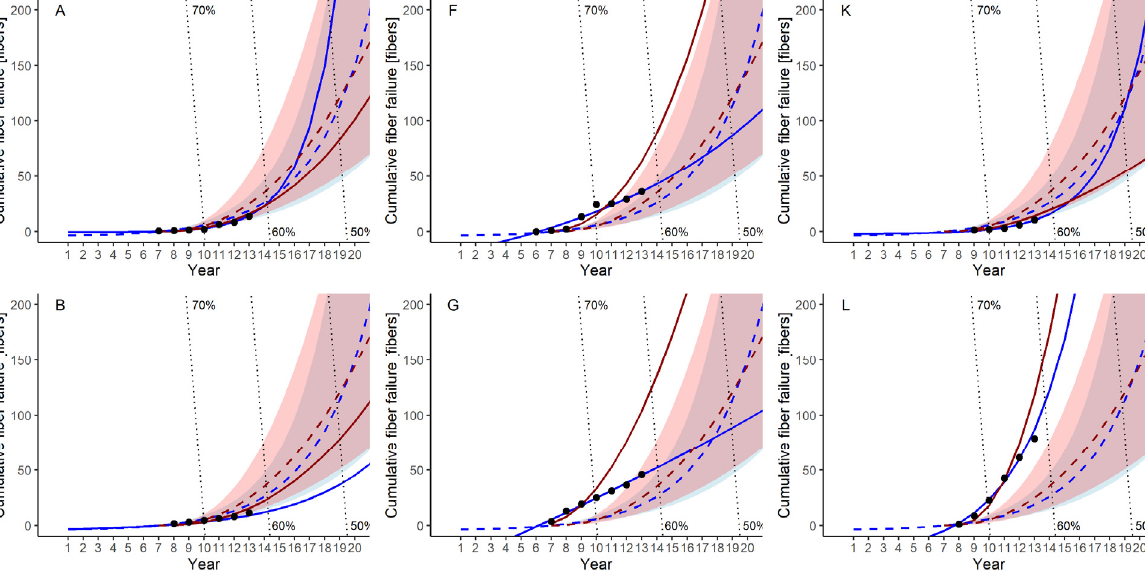
Figure 5. Cumulative failure for each membrane module. Train 1: ( A – E ), Train 2: ( F – J ), and Train 3: ( K – O ). Solid lines indicate curves fit by the power law NHPP model (red) and the log-linear NHPP model (blue), and dashed lines indicate the curves predicted from bootstrapped parameters.